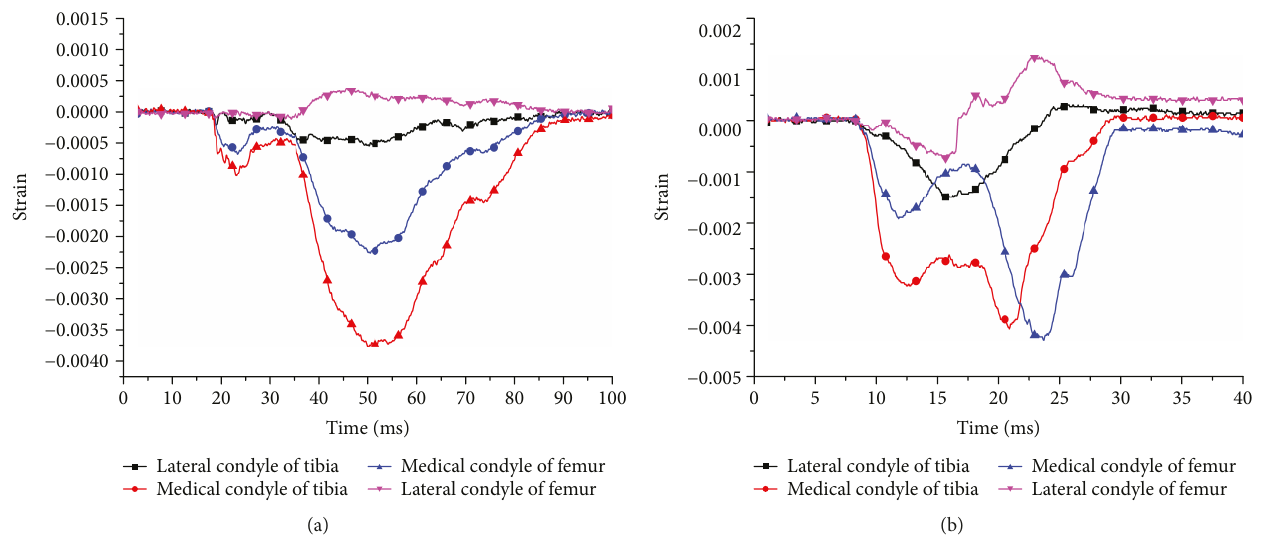
Figure 4: The strain curves of bones in the knee joints at the impact speeds of 2.5 (a) and 5 km/h (b).